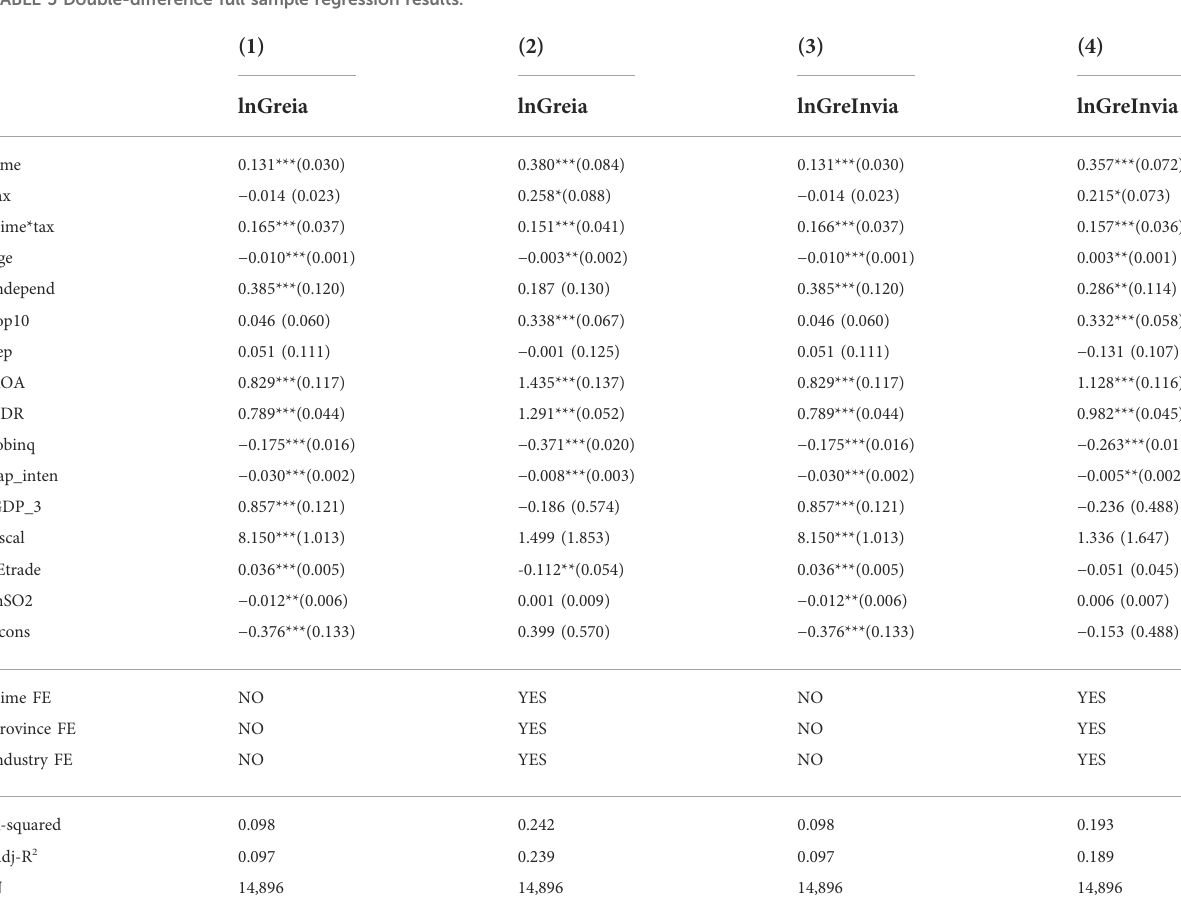
TABLE 5 Double-difference full sample regression